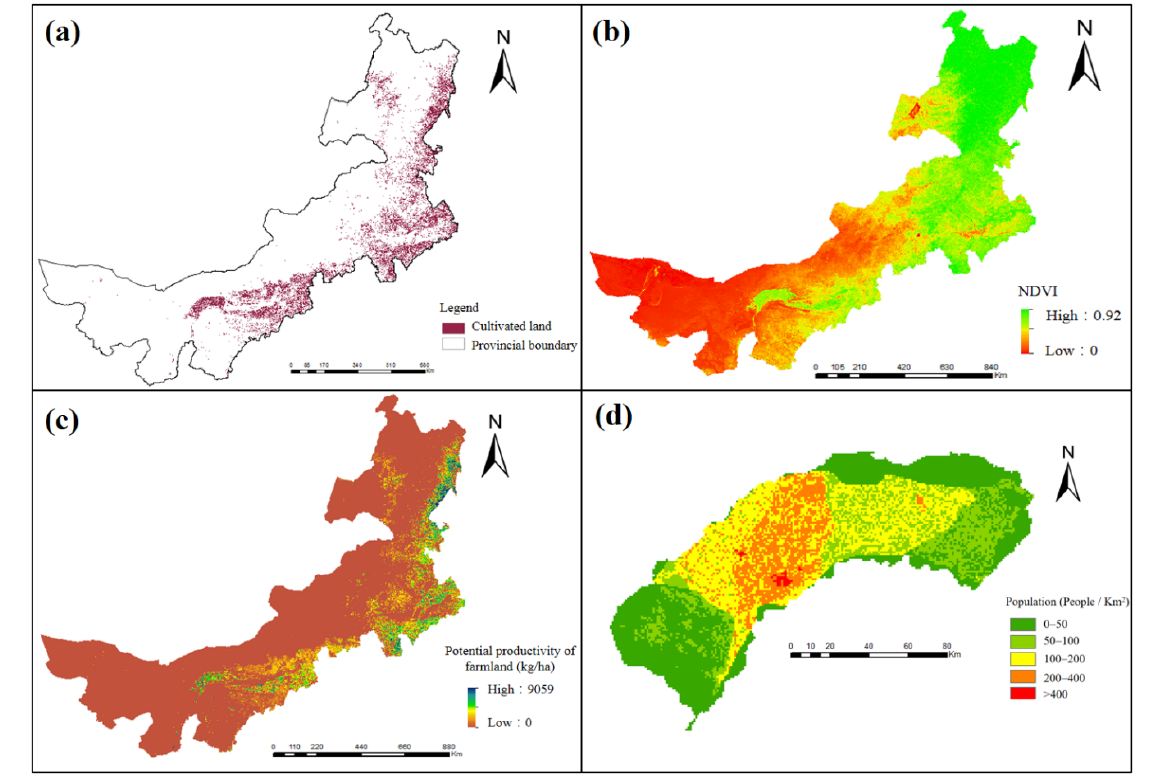
Figure 4. Some basic data of the study area. ( a ) Cultivated land data of Inner Mongolia; ( b ) NDVI data of Inner Mongolia; ( c ) potential productivity of farmland data of Inner Mongolia; and ( d ) population spatial distribution data of HID.